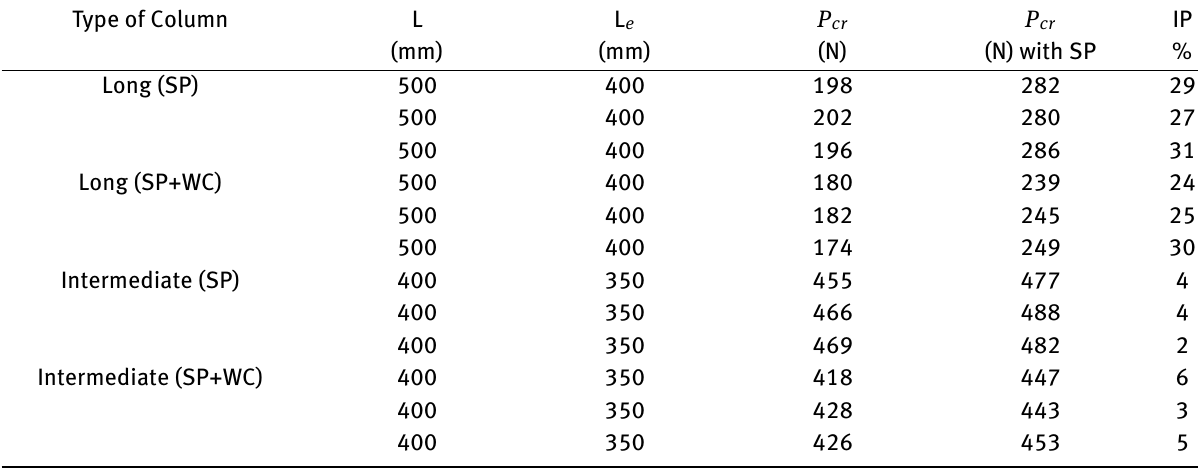
Table 6: The improvement percentage (IP) in the critical buckling loads due to 15 min. shot peening treatment Type of Column